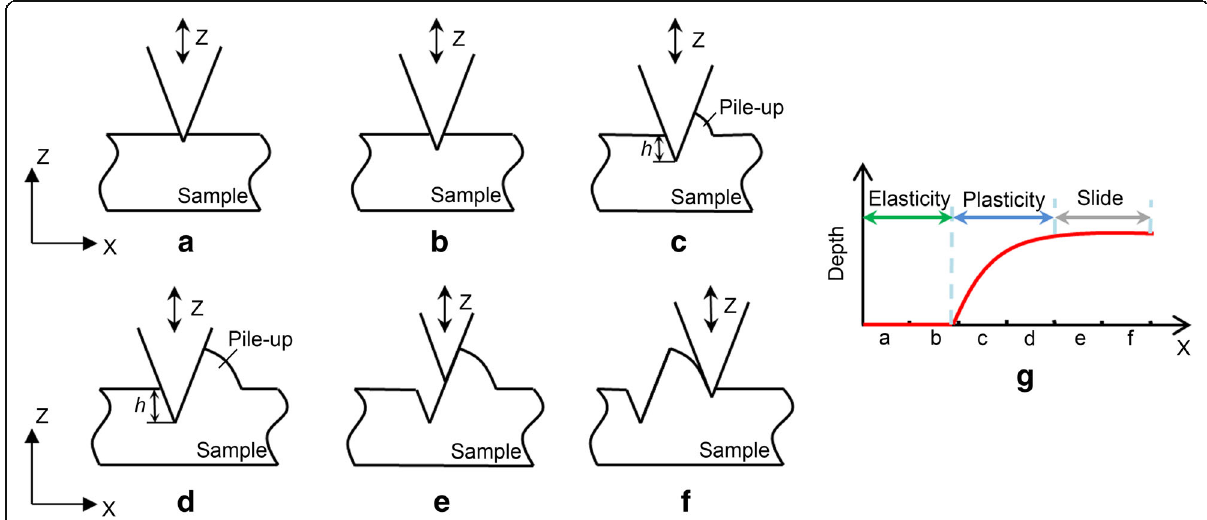
Fig. 6 Schematic of pit formation with a , b elasticity stage, c , d plasticity stage, e , f slide stage, and g precedence diagram of pit